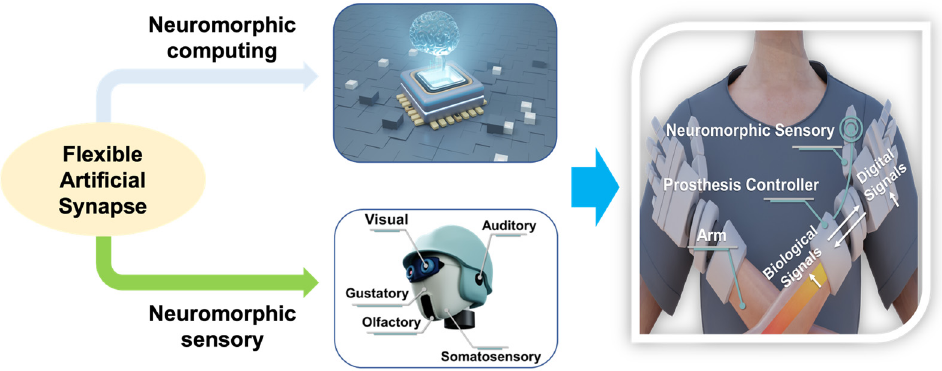
Figure 14. Example of the application of flexible artificial synapse in neuromorphic systems.